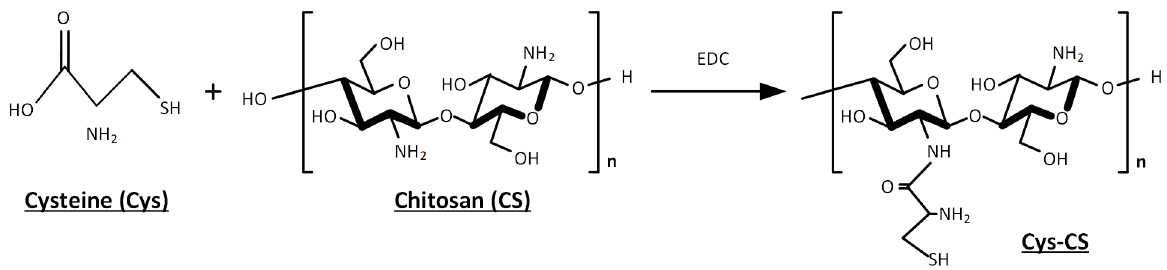
Figure 1. Reaction scheme for the preparation of a conjugated Chitosan (CS with L-cysteine (Cys). After the completion of the reaction and the removal of the remaining water used for washing, the obtained conjugate was received as a white-to-off-white, odorless powder.